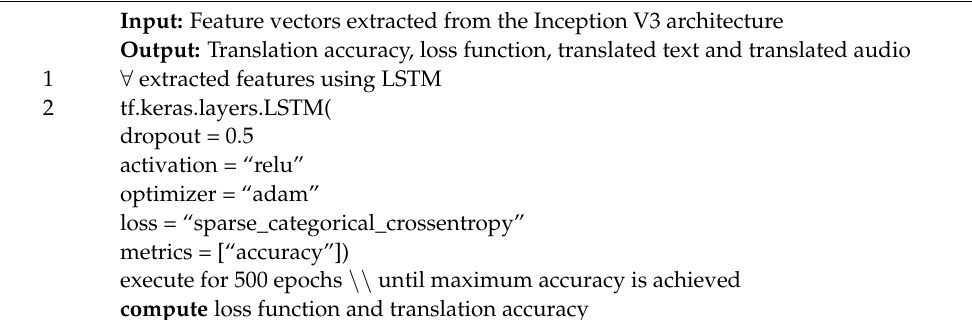
Algorithm 5: Classification Of The Sign Sentences Using